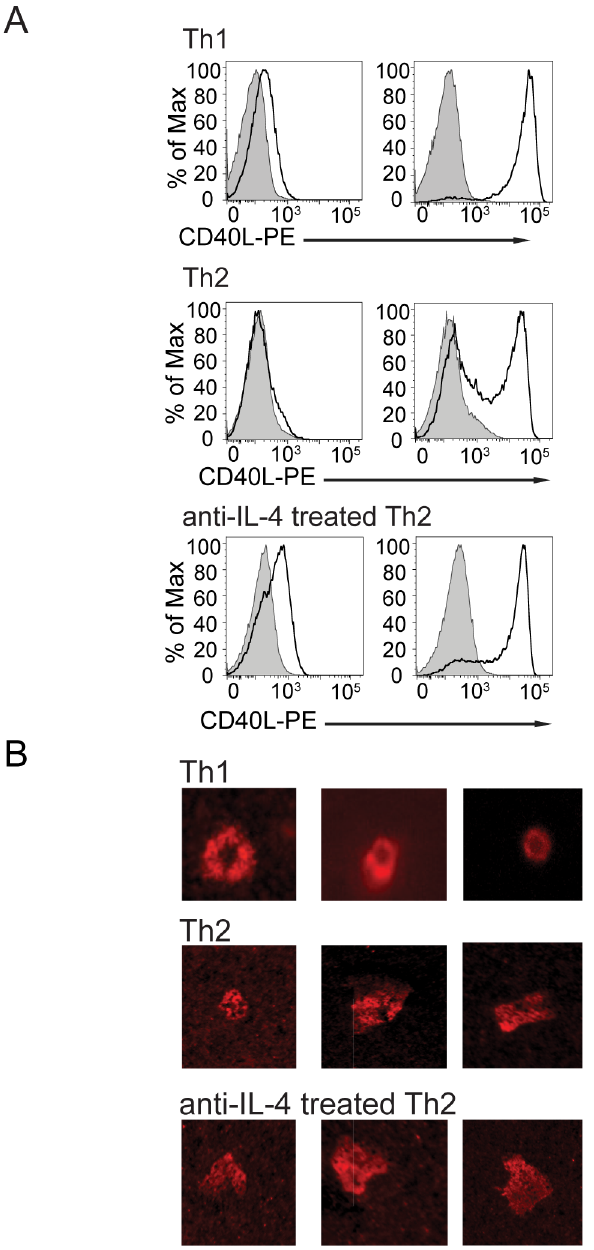
Fig 1. Anti-IL-4 treated Th2 cells retain a pre-formed compartment of CD40Land maintain a multifocal synapse structure. ( A )CD40Lmobilizationto the cellsurfacein 5CC7Th1, 5CC7Th2, andanti-IL-4treated 5CC7Th2 cellsfollowing30minutes(left histogram) or 2 hours(righthistogram)of PMA andionomycin stimulationas detectedby inclusionof PE-labeledanti-CD40Lantibodyduringstimulation.Control,unstimulated Th2 cellsstainedwithPE-labeledanti-CD40L is shownin gray. ( B )Three representative 5CC7Th1, AD10Th2, andanti-IL-4treatedAD10Th2 immunological synapsestructuresare shown.ICAM-Cy5is shownin red. Unlabeled peptide-bound I-E k was includedin the lipidbilayer.Th2 cellsandanti-IL-4-treated Th2 cellswere scoredfor formationof a bull’seyeringof ICAM-1in threeindependentexperiments: 82Th2 cellsand50 anti-IL- 4-treatedTh2 cellswerescoredinExperiment1, 650Th2 and278anti-IL-4-treated Th2 in Experiment 2, and255 Th2 and237anti-IL-4treatedTh2 inExperiment3.